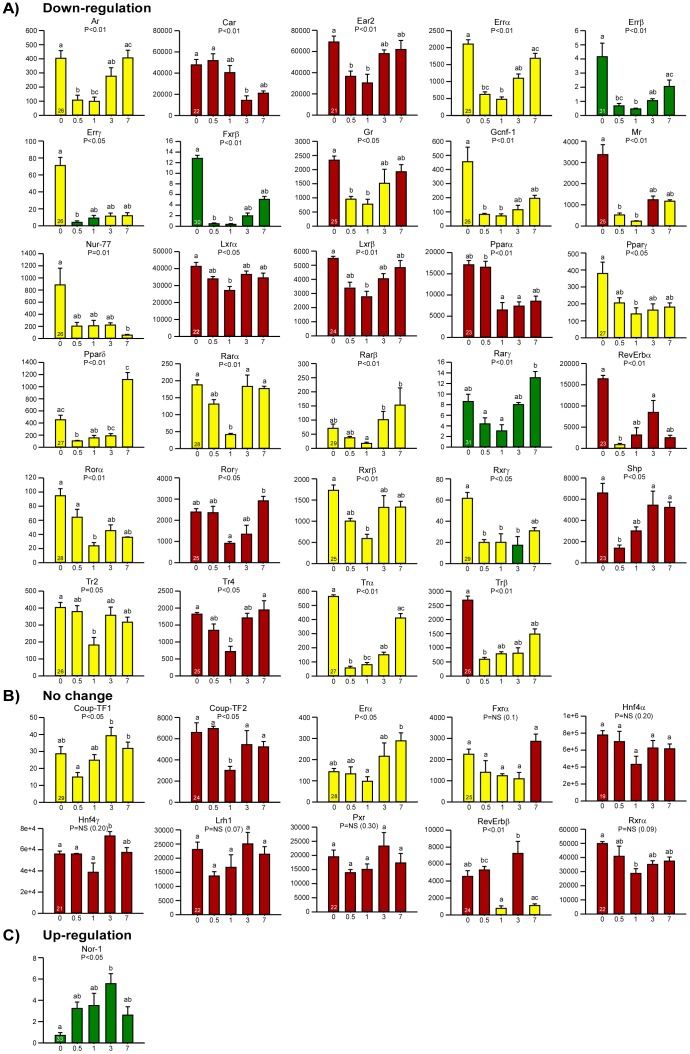
Detailed patterns of NR mRNA expression during LR in mice.(A) After PH, 29 of the 40 NRs expressed in the liver were down-regulated during the priming/proliferative phases of LR, with mRNA expression levels comparable to those of the control liver seven days after PH; (B) 10 NRs did not change significantly during LR; (C) 1 gene showed an increased mRNA expression pattern during the priming and proliferative phases, with mRNA expression levels comparable to those of the control liver seven days after PH. Unexpressed genes (Erβ, Dax-1, Nurr-1, Pnr, Pr, Sf-1, Tlx, Rorβ, Vdr) are not shown. The colors of the columns reflect the expression patterns shown in Figure 1A. Gapdh was used as reference gene, and values were expressed as relative units. Cycle time numbers at RTqPCR are reported in the “Day 0” bar. All the results are shown as mean ± SEM. Lower case letters indicate statistical significance (p≤0.05), assessed by the Kruskal-Wallis One-Way ANOVA on Ranks plus Nemenyi-Damico-Wolfe-Dunn post-hoc test (n = 4–5 at each time point); “a” means reference group; “b” means different from “a”; “a, b” means equal to both “a” and “b”; “c” means different from “a” and “b”; “a, c” means equal to both “a” and “c” and different from “b”; “b, c” means equal to both “b” and “c” and different from “a”.